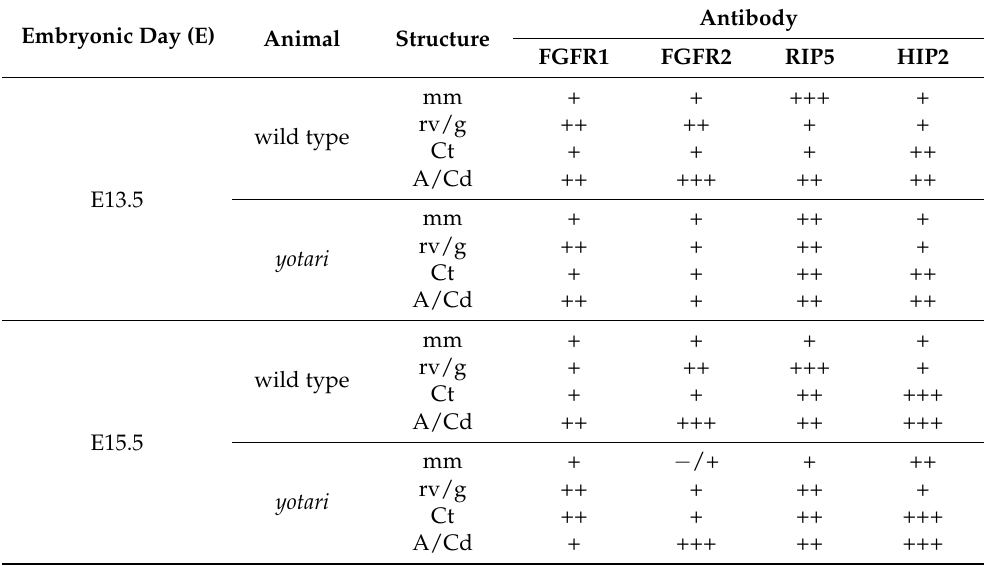
Table 1. Staining intensity of specific antibodies in the kidneys of yotari and wild-type mice at embryonic days E13.5 and